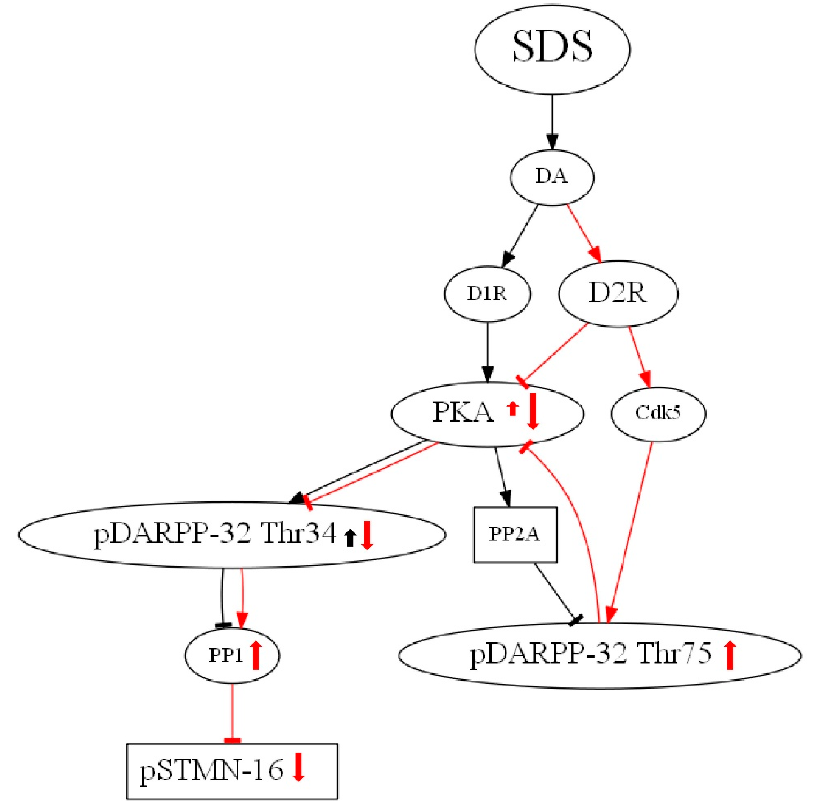
Figure 8. Mechanisms illustrating how social defeat stress may affect expression of pDARPP-32 Thr34, pDARPP-32 Thr75 and pSTMN-16.